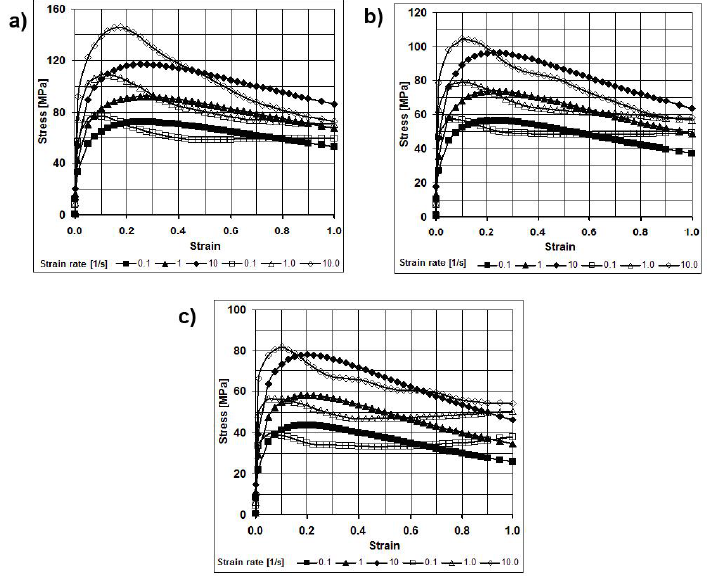
Figure 1. Plastic flow curves for the AZ31 magnesium alloy for temperatures: ( a ) 350 °C, ( b ) 400 °C, ( c ) 450 °C [33]. Table 2. Parameters of function (1) for the AZ31 magnesium alloy